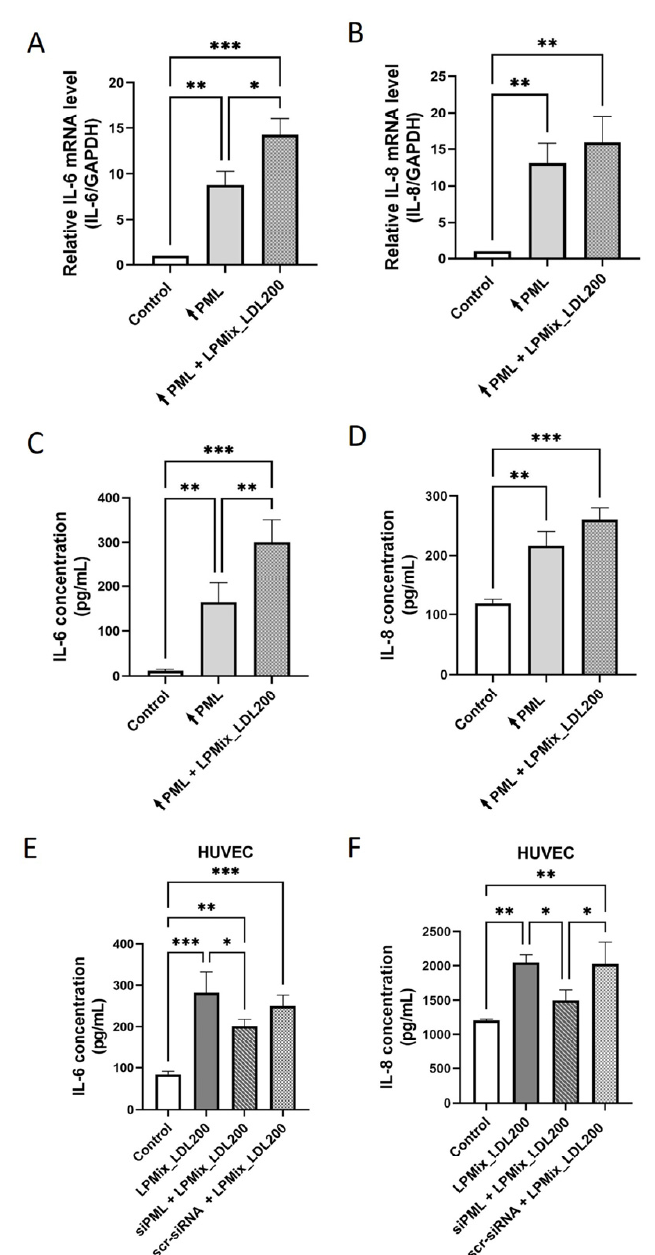
Figure 4. PML mediates LDL-triggered upregulation of IL-6 and IL-8 expression in endothelial cells. ( A – D ) IL-6 ( A ) or IL-8 ( B ) mRNA and IL-6 ( C ) or IL-8 ( D ) protein (ELISA on cell supernatants) levels were determined in EA.hy926 cells either transfected with a vector lacking a specific gene insert (control) or a pEGFP-C1-PML-IV-vector ( ↑ PML) co-incubated without or with an LPMix supple- mented with high LDL concentration for 24 h. n = 3, two-way ANOVA. ( E , F ) IL-6 ( E ) or IL-8 ( F ) protein levels in supernatants of HUVECs incubated with an LPMix supplemented with high LDL concentrations for 24 h with or without simultaneous transfection with either PML -specific siRNAs